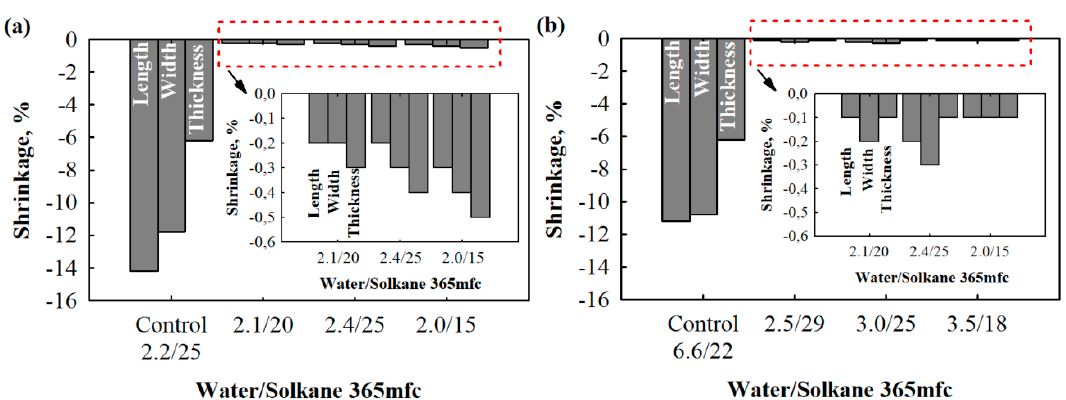
Figure 3. Shrinkage of specimens cut for thermal conductivity test 2 days after production: ( a ) 40 kg / m 3 and ( b ) 30 kg / m 3 .